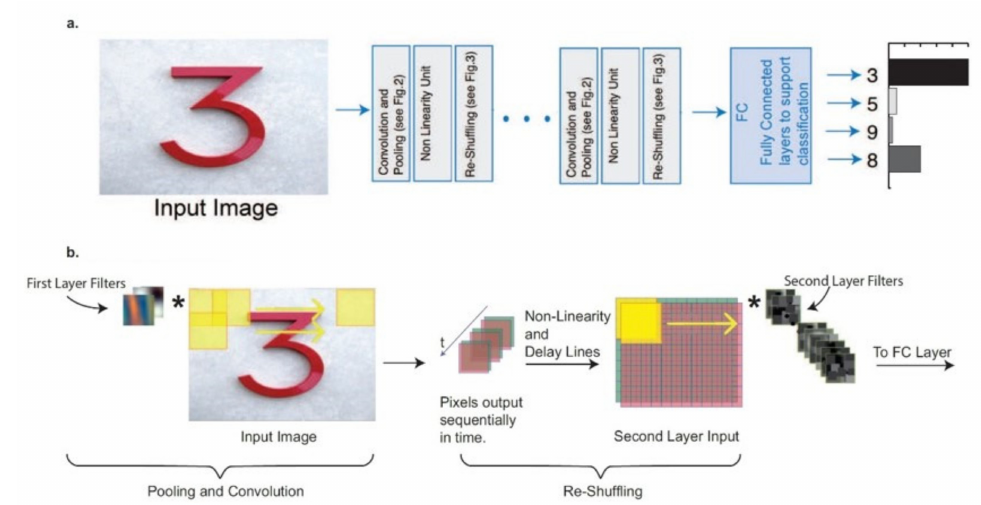
Figure 9. The suggested architecture for a fully optical CNN. ( a ) Logic Block Diagram and ( b ) Schematic Illustration